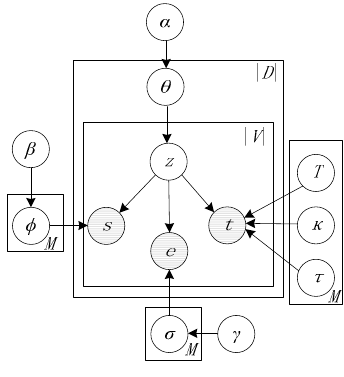
Figure 5. The graphical model of STPT.